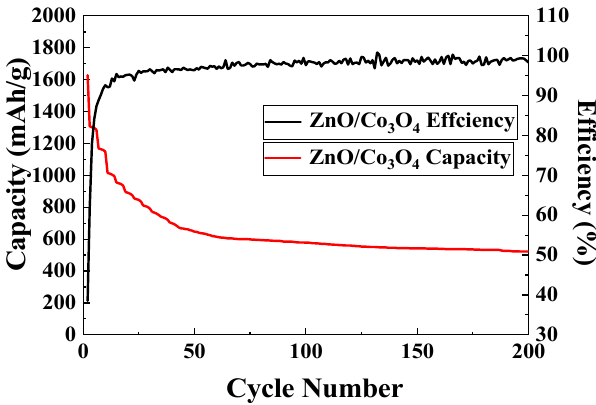
Figure 7. Cyclic performance curve of ZnO/Co 3 O 4 .